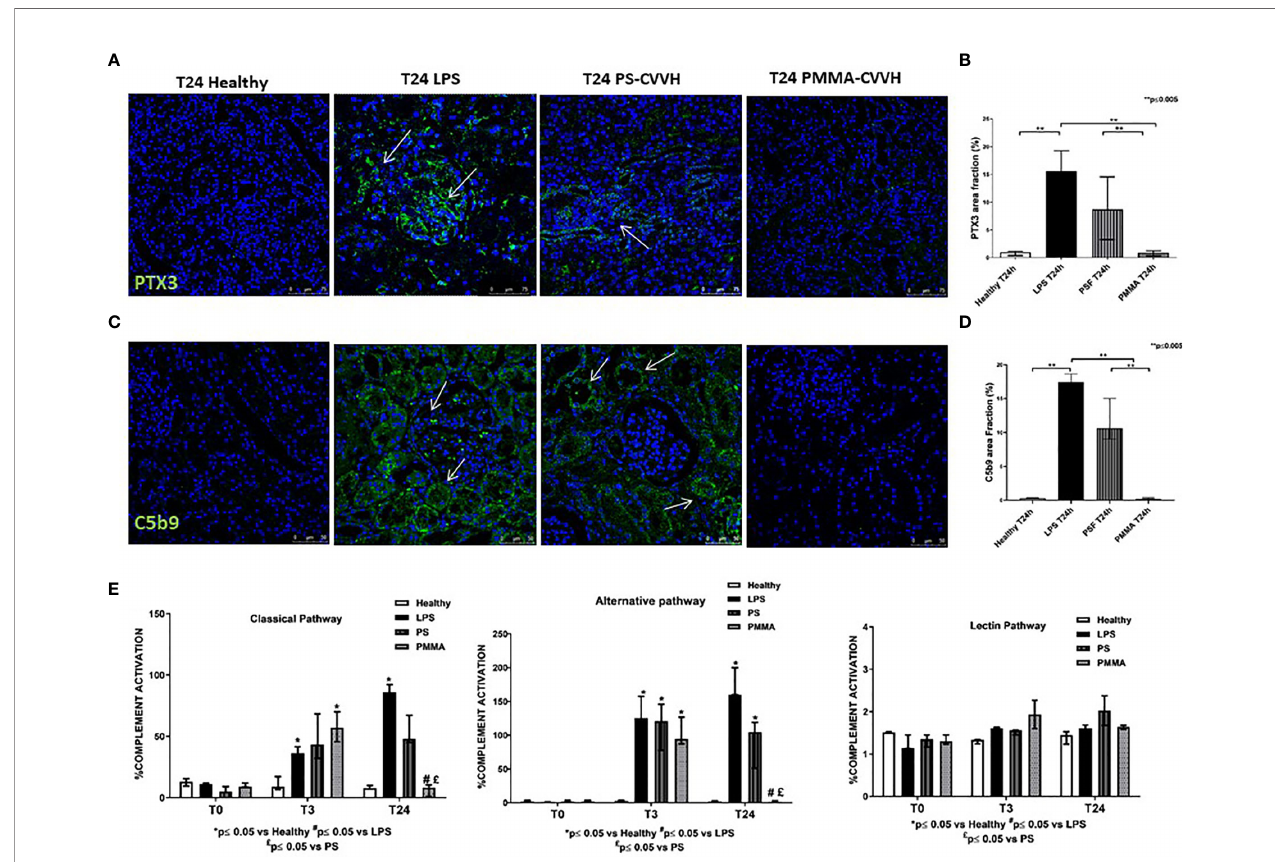
FIGURE 4 | PMMA-CVVH treatment reduced PTX3 deposits and local and systemic Complement activation. (A) In healthy pigs, no PTX3 deposits (green) were found. A signi fi cant increase in PTX3 deposits were observed at peritubular and glomerular level (white arrows) in LPS group. PS-CVVH reduced PTX3 deposits. PMMA-CVVH treatment signi fi cantly reversed LPS effects, respect to both LPS and PS-CVVH group. Magni fi cation 630×. The fl uorescent dye To-pro 3 was used to counterstain nuclei (blue). (B) C5b9 deposits (green) were observed at tubular and glomerular level in endotoxemic pigs (white arrows). Renal C5b-9 staining was still detected in PS-CVVH group (white arrows). A signi fi cant decrease of C5b-9 deposits was observed after PMMA-CVVH treatment. Magni fi cation 630×. The fl uorescent dye TOPRO was used to counterstain nuclei (blue) The quantitative analyses of PTX3 (C) and C5b-9 staining (D) were obtained as described in the Methods section and expressed as median ± IQR of at least fi ve pigs for each group (Healthy and PMMA T24 group, n = 7, LPS T24 n = 5, PS T24 n = 6). Statistically signi fi cant differences were assessed by the Mann – Whitney test (**p < 0.005). (E) Wieslab assay revealed systemic activation of complement classical and alternative pathway in endotoxemic swine sera after 3 and 24 h from LPS injection. PMMA-CVVH treatment signi fi cantly decreased both CP and AP ( # p < 0.05 vs LPS, and £ p < 0.05 vs PS). PS-CVVH treatment did not reduce systemic complement activation. Results represent the median ± IQR of at least fi ve pigs for each group (Healthy group and PMMA group, n = 7 for all time points; LPS group, T0-T3 n = 7, T10 -T24 n = 5; PS group, T0-T3-T10 n = 7 and T24 n = 6). Statistically signi fi cant differences were assessed by the Mann – Whitney test (*p < 0.05 vs Healthy, # p < 0.05 vs LPS, and £ p < 0.05 vs